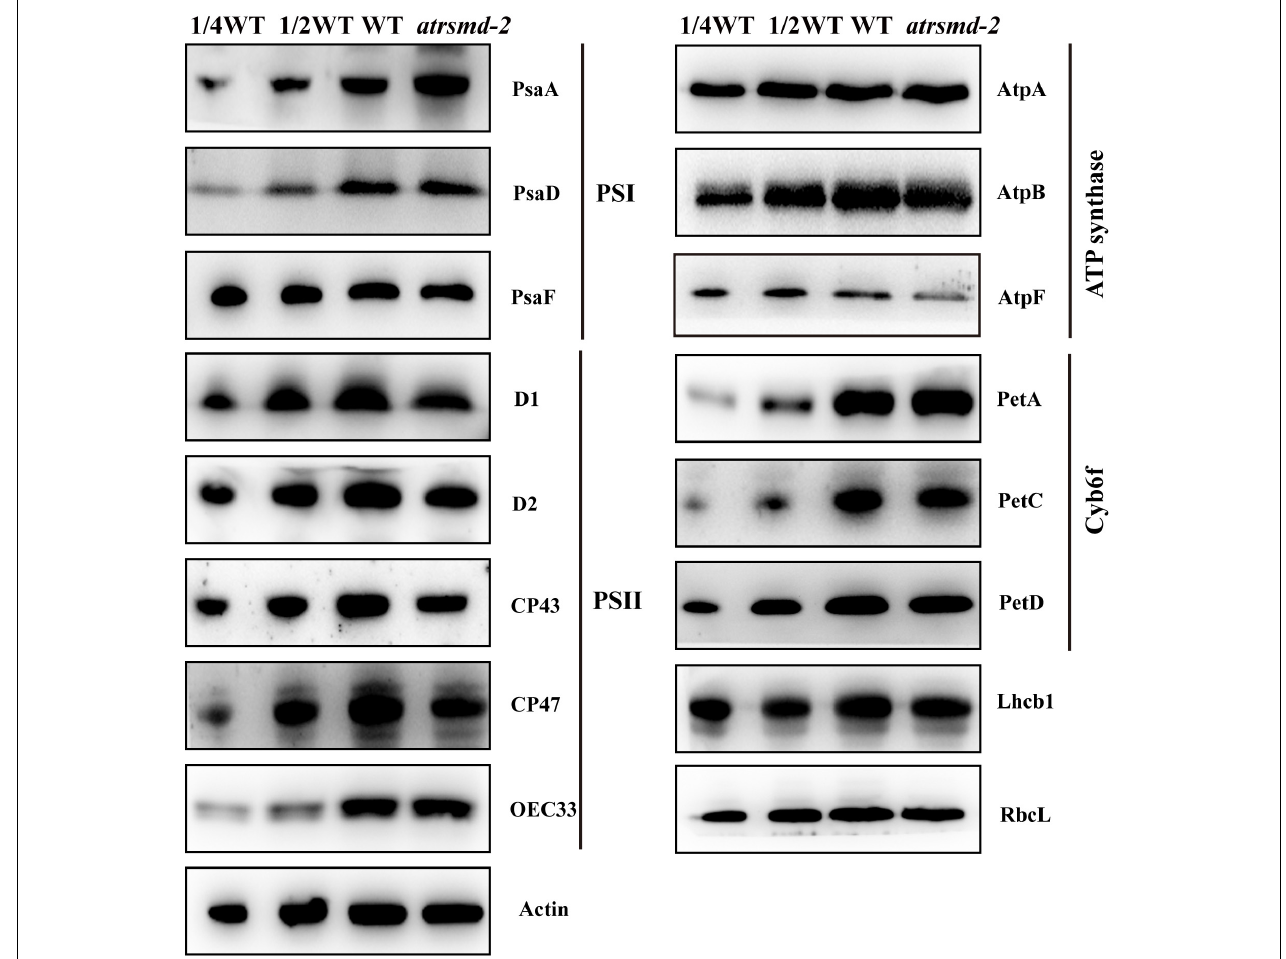
FIGURE 4 | Immunoblot analysis of the photosynthetic proteins from the wild type (WT) and atrsmd-2 mutant. Total protein samples were prepared from 14-day-old emerging leaves of the wild type and atrsmd-2 mutant and then separated by SDS–PAGE. Immunoblot analysis of the photosynthetic proteins PsaA, PsaD, PsaF, D1, D2, CP43, CP47, OEC33, AtpA, AtpB, AtpF, PetA, PetC, PetD, Lhcb1, and RbcL using the corresponding antibodies was performed. Total proteins from the WT samples were loaded at three different concentrations (2.5, 5, and 10 µ g), and total proteins from the mutant samples were loaded at 10 µ